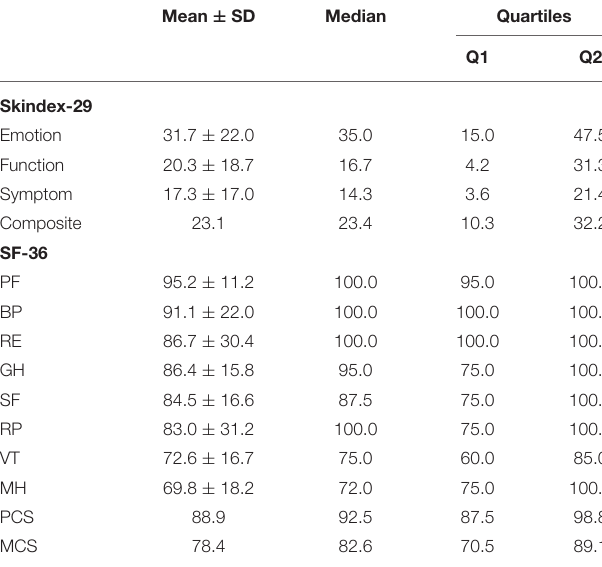
TABLE 3 | Statistics of subscales of Skindex-29 and SF-36 in patients with